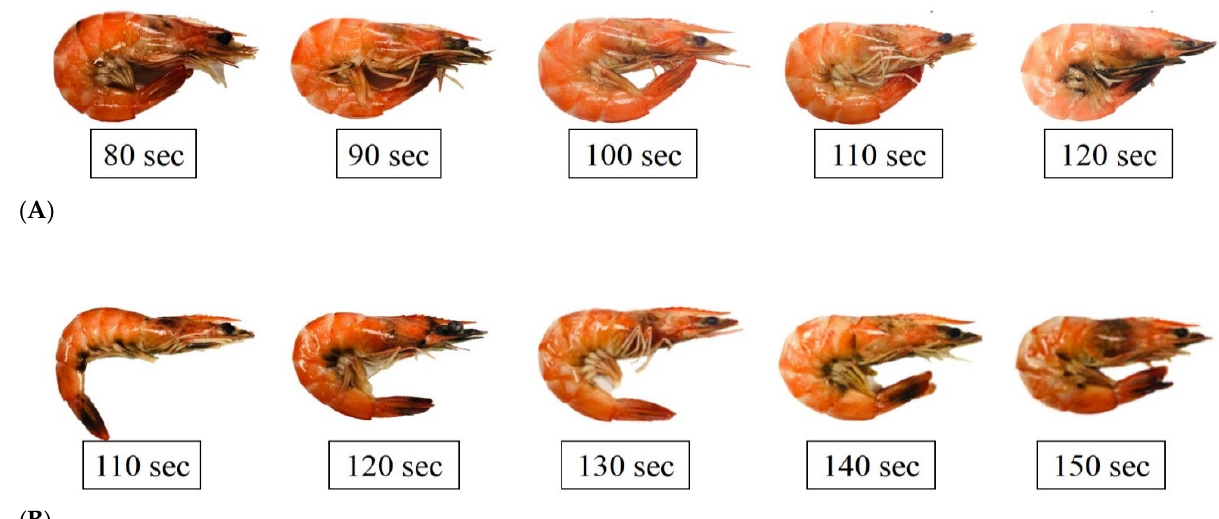
Figure 2. Appearance changes of white shrimp using the scaled-up MAIH system set at 130 °C ( A ) and 90 °C ( B ) for various heating times.